Question: State the chart type depicted above.
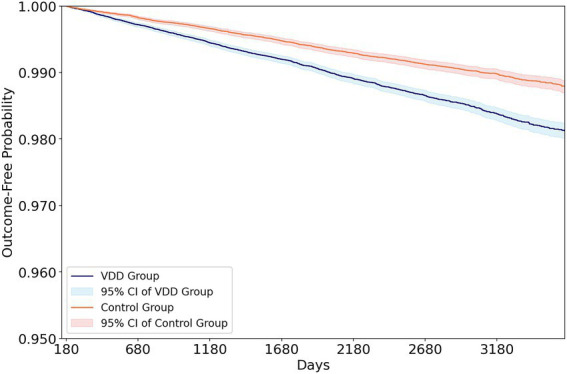
Answer: survival